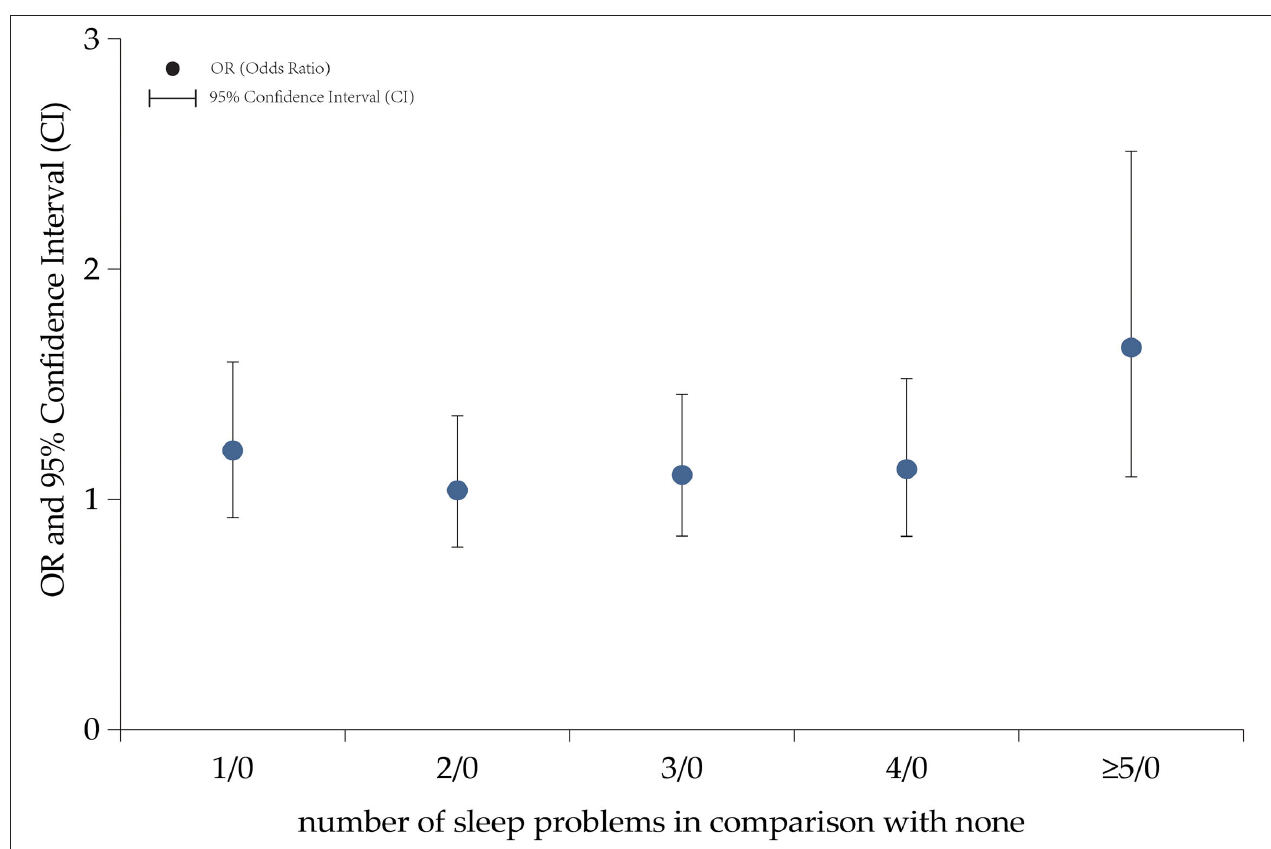
FIGURE 2 | The association between preterm birth and number of sleep problems in kindergarten children aged 3–6 years. In comparison with children without sleep problems, children with sleep problems were more likely to be preterm children, odds ratio (OR) = 1.21 and 95% confidence interval [CI] (0.92–1.60) for 1 sleep problem, OR = 1.04 and 95% CI (0.79-1.36) for 2 sleep problems, OR = 1.11 and 95% CI (0.84–1.46) for 3 sleep problems, OR = 1.13 and 95% CI (0.84–1.53) for 4 sleep problems, and OR = 1.66 and 95% CI (1.10–2.51) for 5 sleep